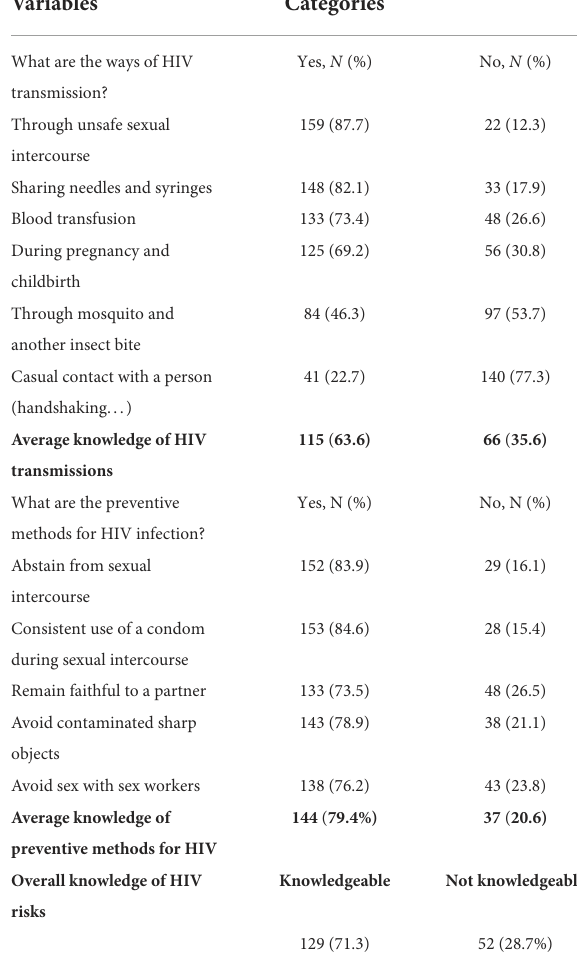
TABLE 2 The respondents’ knowledge of HIV/AIDS in Andabet district, Ethiopia,